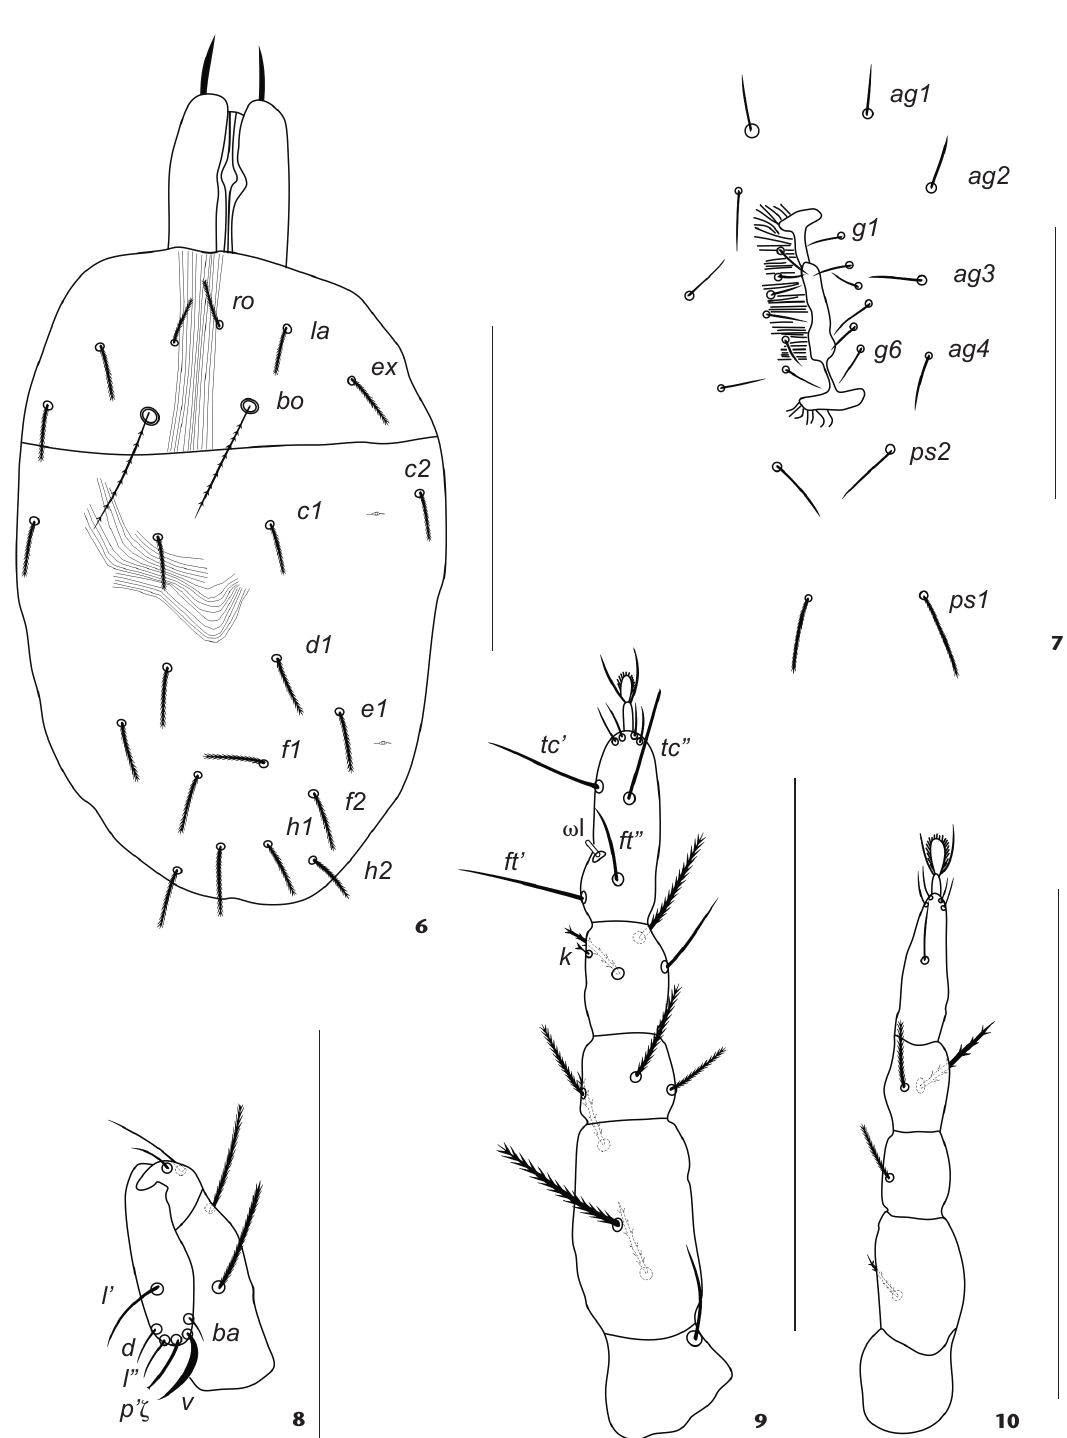
8Figures 6-10. Quasitydeus feresi sp. nov. , female holotype: (6) dorsal view; (7) anogenital area; (8) palp; (9) leg I; (10) leg III. Scale bars: 6, 9, 10 = 10 µm, 7, 8 = 50 ZOOLOGIA 33(2): e20150130 | DOI: 10.1590/S1984-4689zool-20150130 | April 29, 2016 5 /